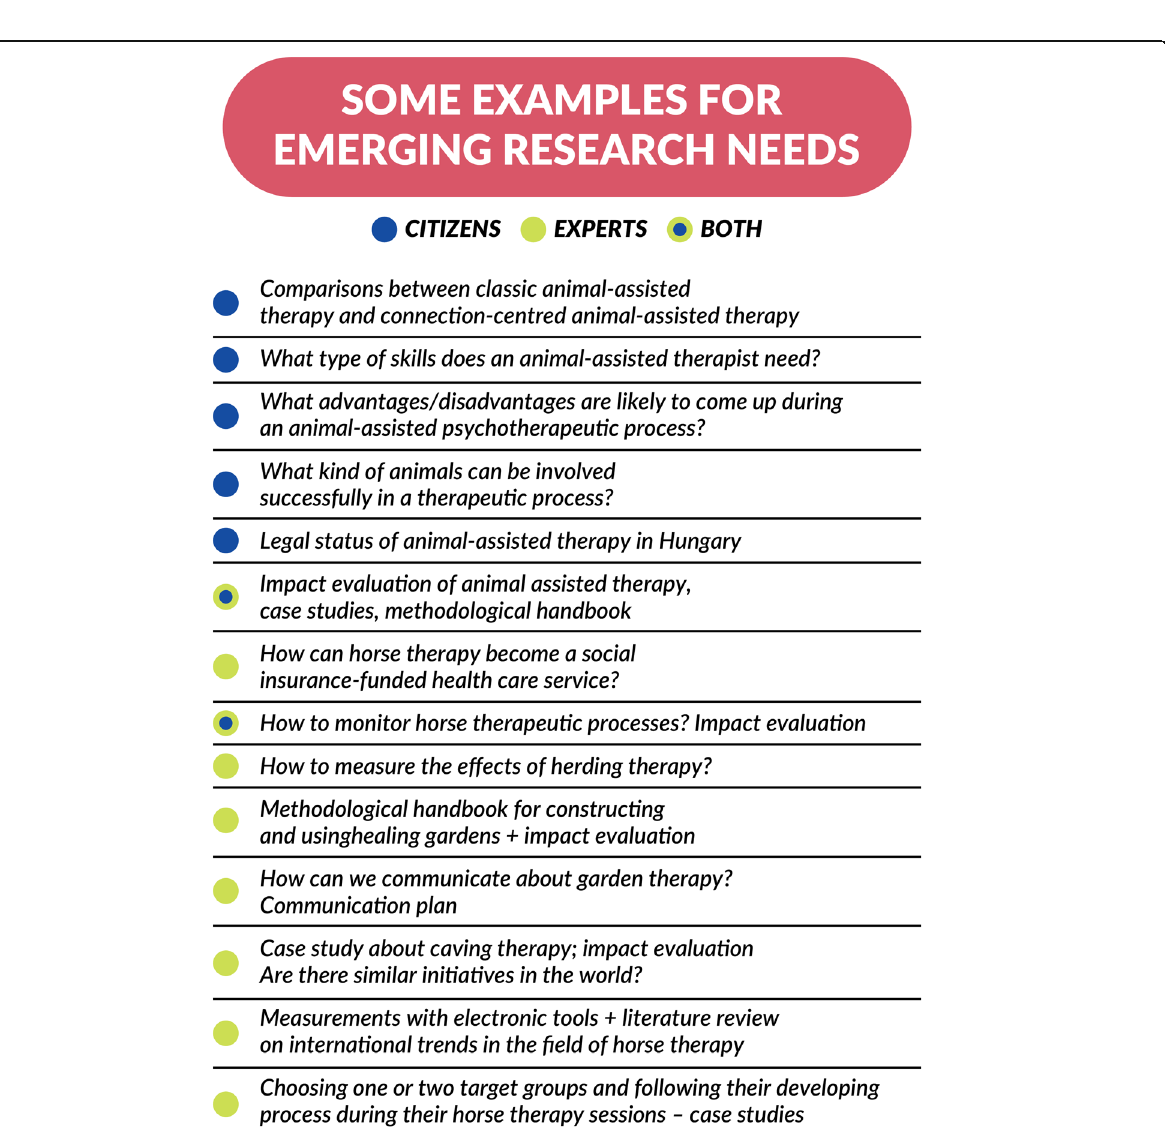
Fig. 1 Some examples of the emerging research needs — pieces from the co-created